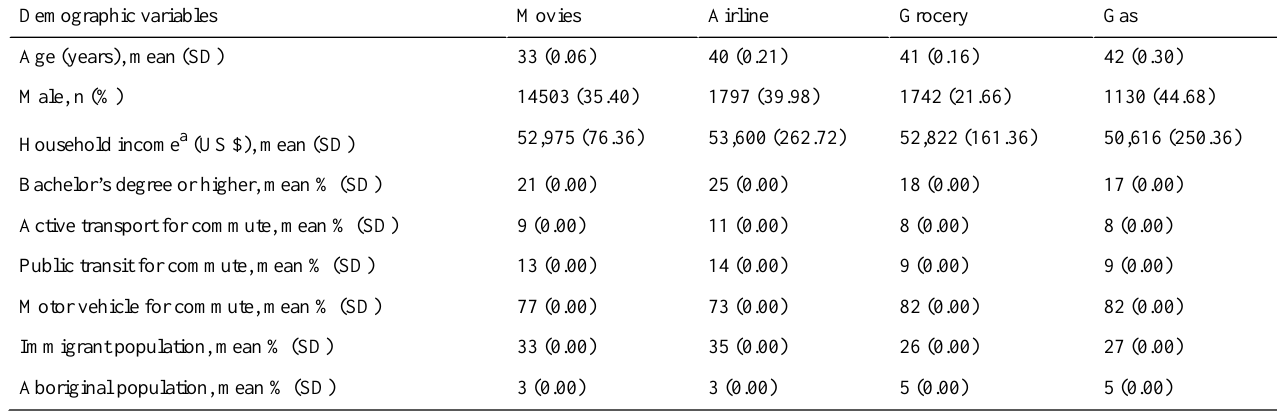
Table 2. Demographic characteristics of the rewards program (census-level data at the forward sorting area level). GasGroceryAirlineMoviesDemographic